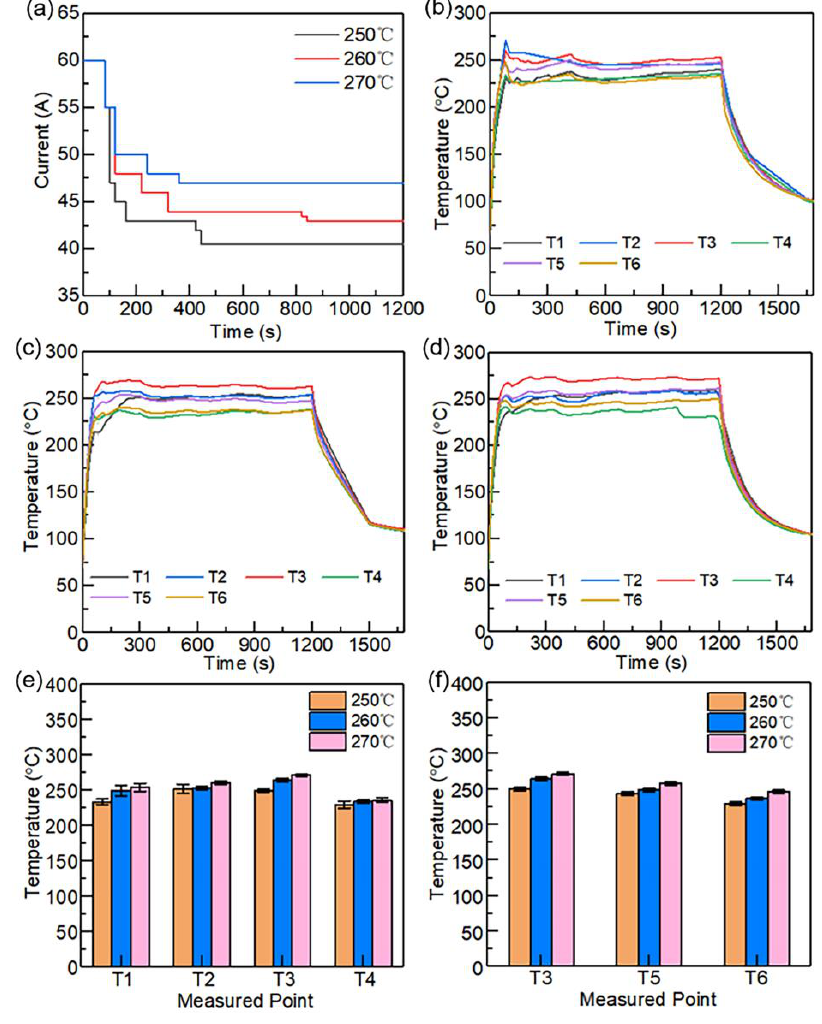
Figure 5. Input currents and corresponding temperature responses: ( a ) input current required for different forming temperatures; ( b ) heating curves at different positions under the forming temperature of 250 °C; ( c ) heating curves at different positions under the forming temperature of 260 °C; ( d ) heating curves at different positions under the forming temperature of 270 °C; ( e ) average temperatures at different positions along the thickness direction; ( f ) average temperatures at different positions along the in-plane direction.